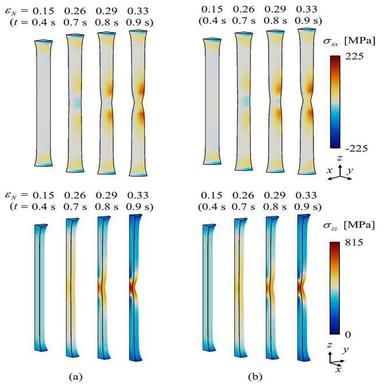
Distributions of the Cauchy stress σxx (upper row) and σzz (lower row) at εN = 0.15, 0.26, 0.29, and 0.33 (i.e., t = 0.4, 0.7, 0.8, and 0.9 s) obtained from (a) the results of the virtual experiment and (b) the results of the simulation using the optimally estimated parameters. For visualization, the distributions are plotted on the quarter-specimen model, which is expanded based on the symmetry of the specimen model.